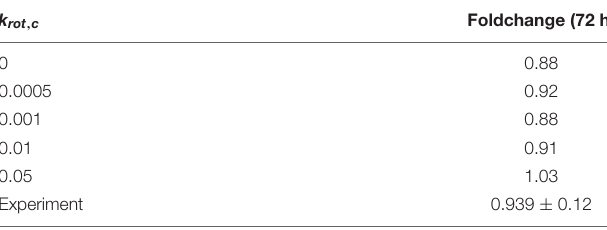
TABLE 3 | The influence of k rot , c on cell fold change.